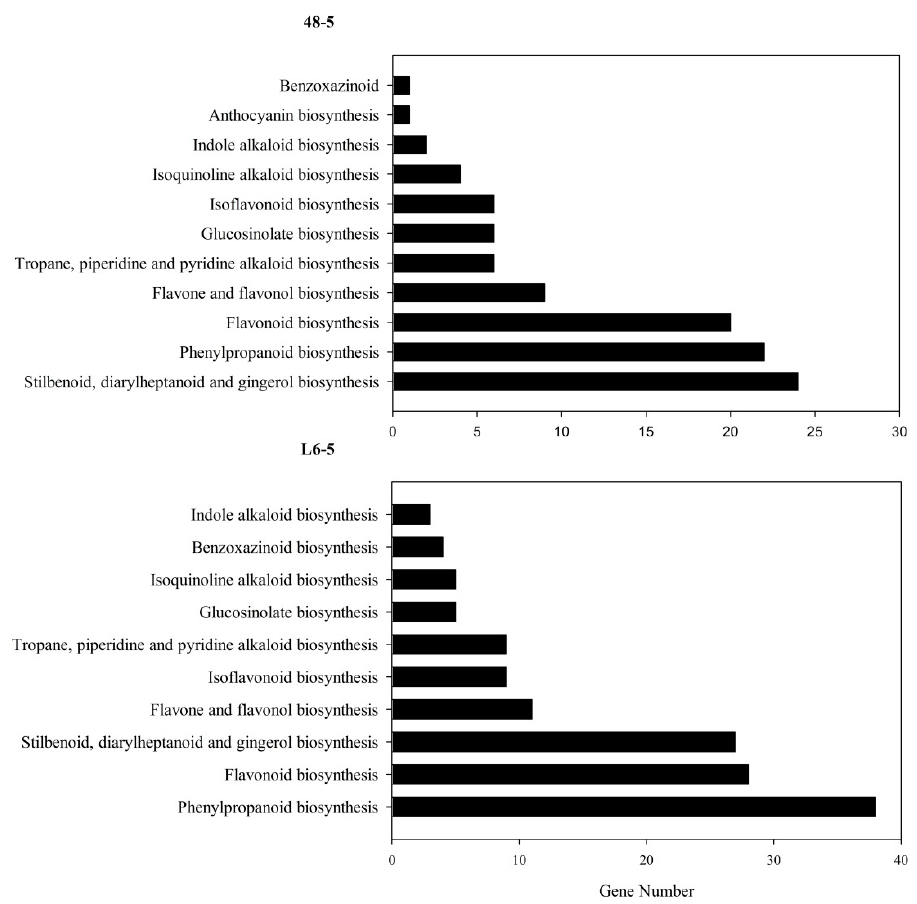
Figure 5. Biosynthesis of other secondary metabolites KEGG of the high-impact mutations gene in the four EMS-induced eggplant mutants. The high-impact mutations gene include the nonsense mutations and frameshift mutations genes. 48-5 and L6-5 were white fruit mutants.